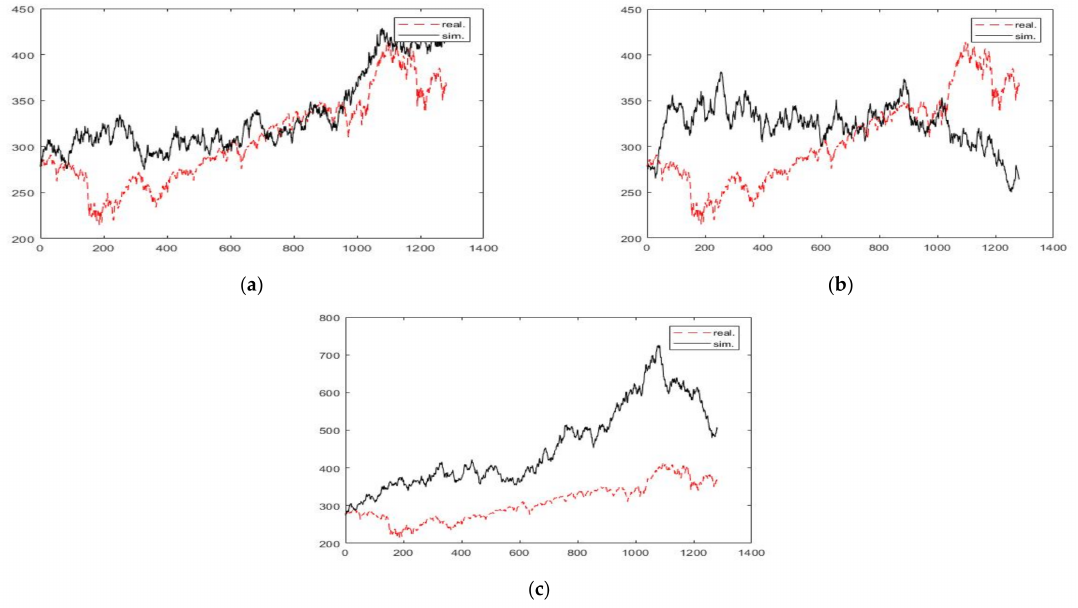
Figure 6. Simulation results using GBM (5-year period): ( a ) Hurst PE, ( b ) Hurst RS, ( c ) Hurst